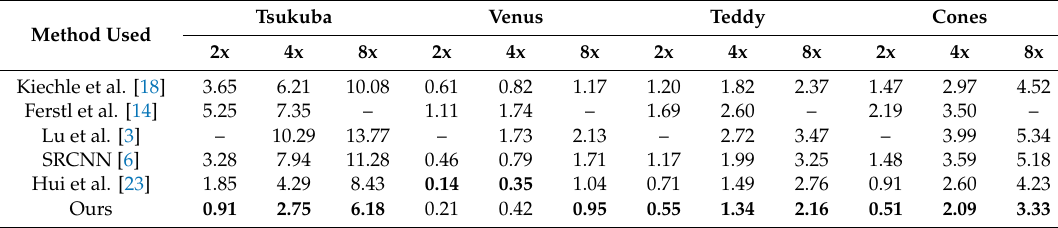
Table 3. Quantitative comparison (in RMSE) on dataset C